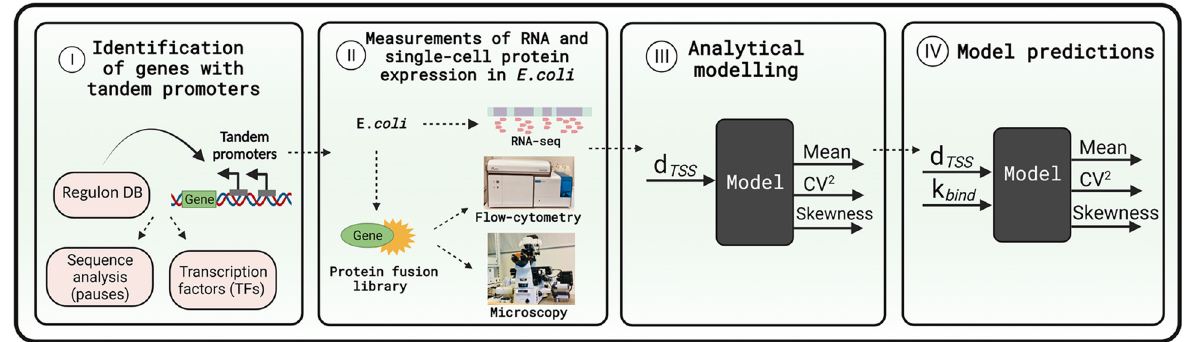
Fig 2. Workflow. (I) We identified genes controlled by tandem promoters in Regulon DB. (II) Next, we measured the single-cell protein levels of those genes with arrangements I and II that are tagged in the YFP strain library [28]. We also measured the mean RNA fold changes of these genes over time (S1 Appendix, section ‘RNA-seq measurements and data analysis’). (III) We used the single-cell data to tune the model. (IV) Finally, we used the model to explore the state space of protein expression. Figure created with BioRender.com.